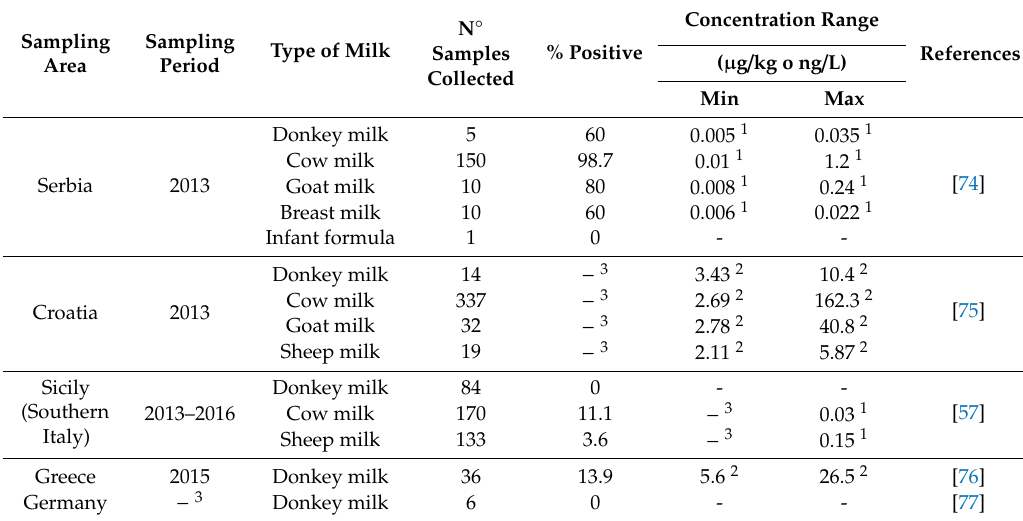
Table 3. Results of surveys carried out on donkey milk and other types of milk to monitor AFM 1